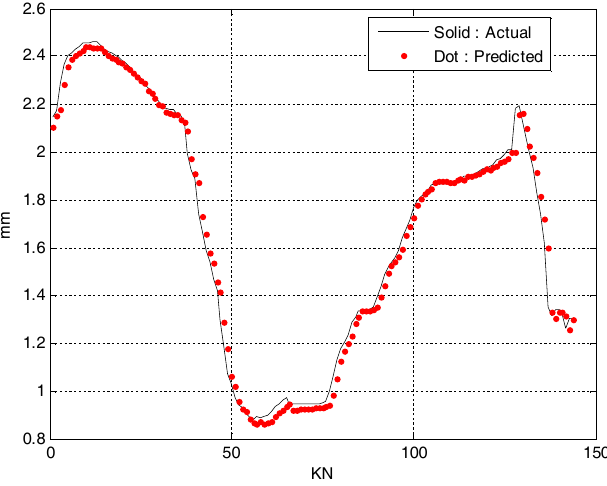
Figure 9. Validation for no-fines lightweight concrete wall with the horizontal reinforcement.